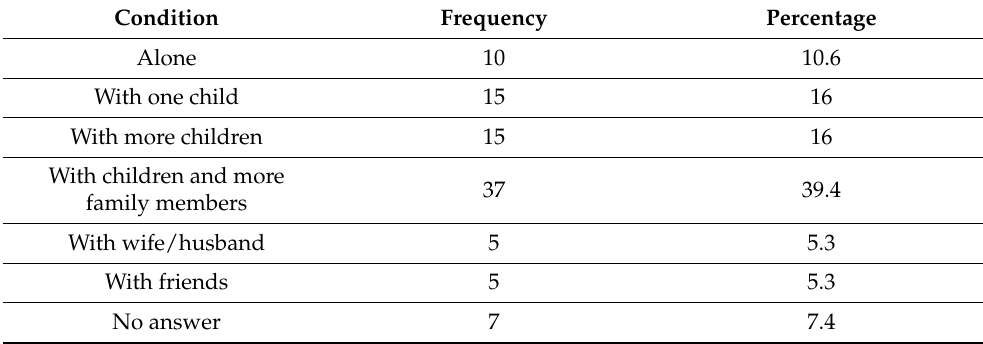
Table 1. Company during